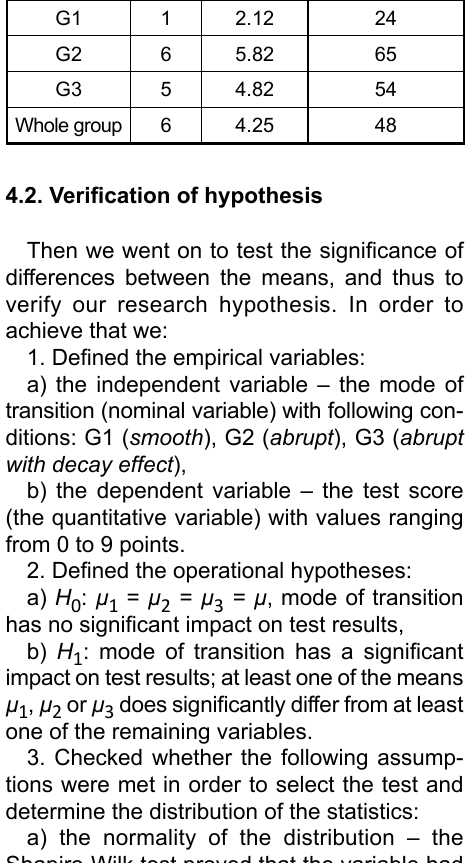
Table 1. The comparison of basic results in respecti - ve experimental groups